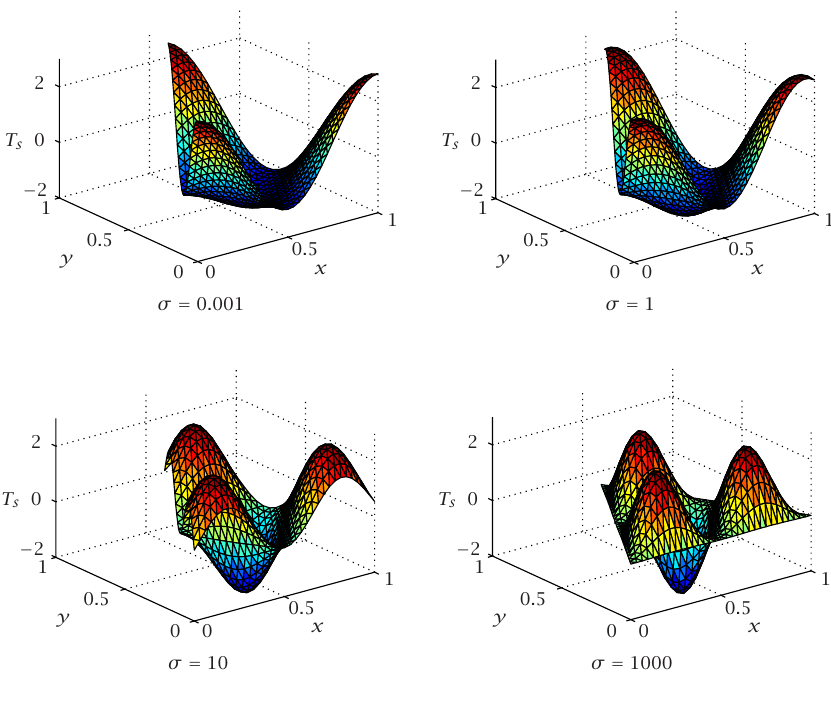
Figure 7.1 . The ( 1 , 1 ) symmetric